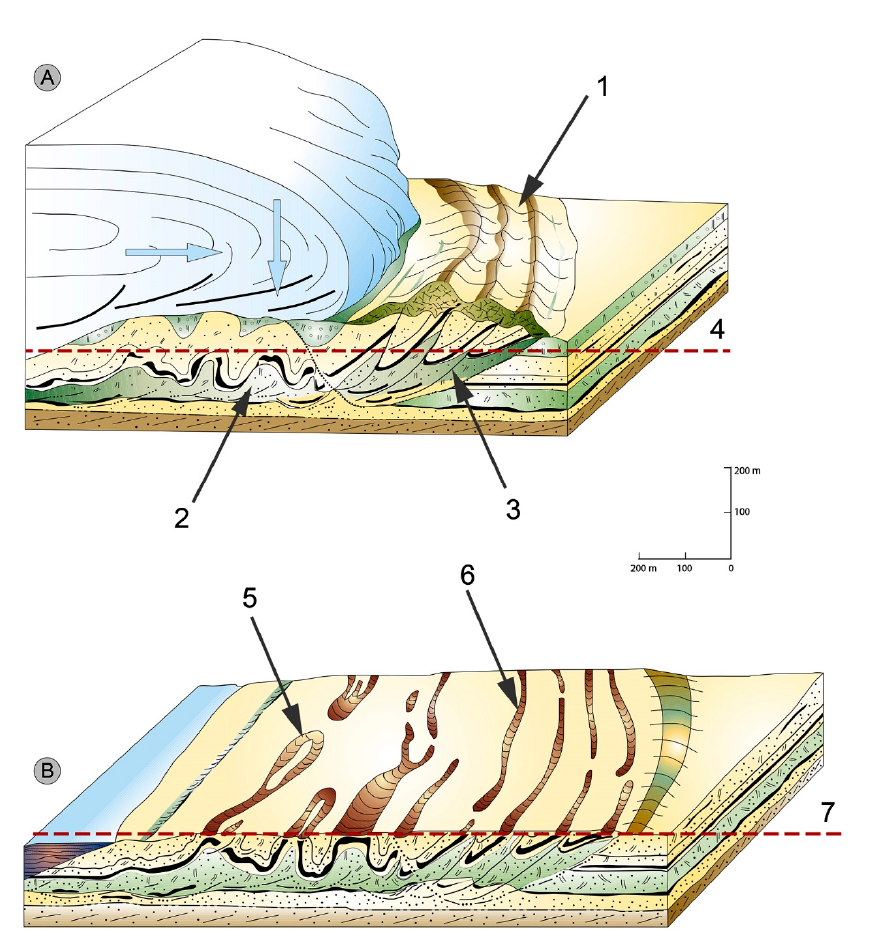
Figure 2. General ideological model of the deformation and erosional processes in the area of the transboundary Muskau Arch ([51] after [53]): ( A ) The approximately 430–510 m thick glacier dislocates the horizontal layered bed of tertiary and quaternary deposits by loading and horizontal push. The glacier acts down to a depth of about 270–290 m beneath the ice base. 1—terminal moraine; 2—fold and diapir structures; 3—scale structures; 4—level of moraine erosion. ( B ) The contemporary shape of the coal seam outcrop, depending on the type of glaciotectonic structures. 5—brown coal deposits associated with folds and diapirs; 6—brown coal deposits associated with scales; 7—present day level of terminal moraine erosion.